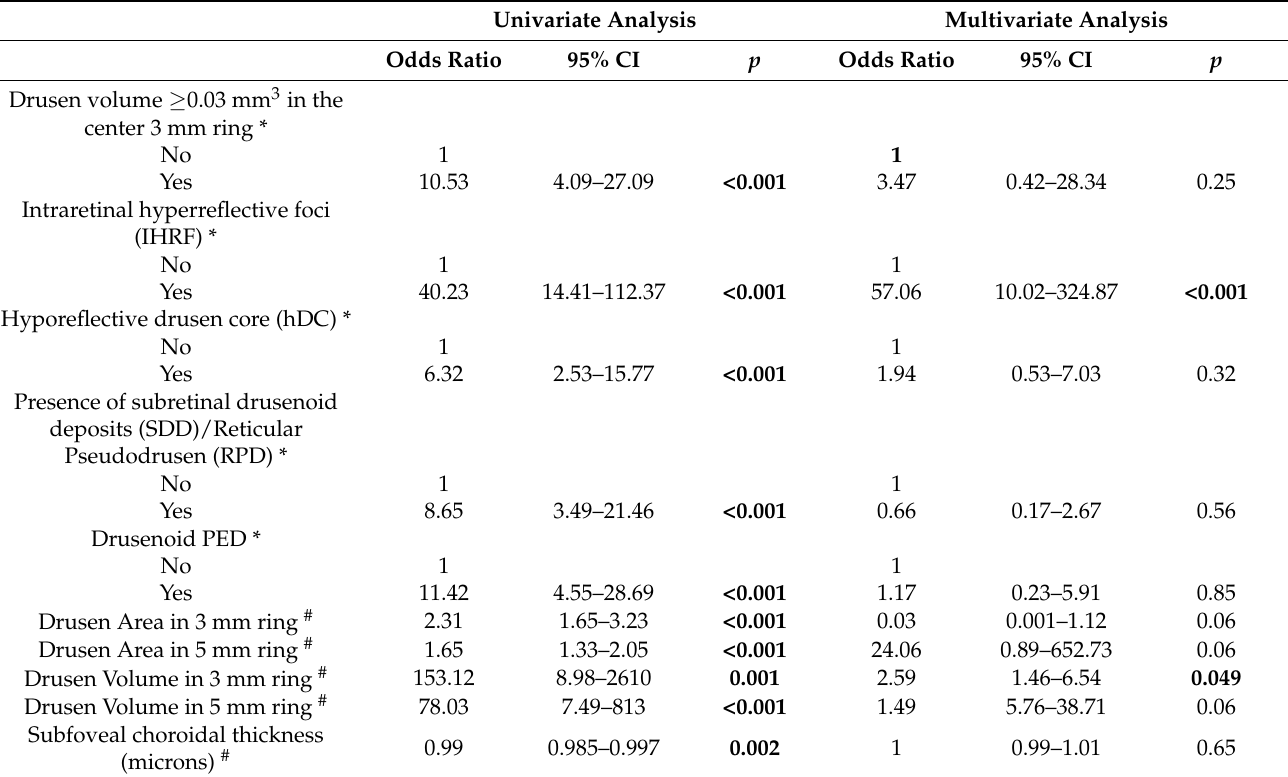
Table 1. Regression Analysis to Study the Effect of Various Biomarkers on GA incidence. Univariate Analysis Multivariate